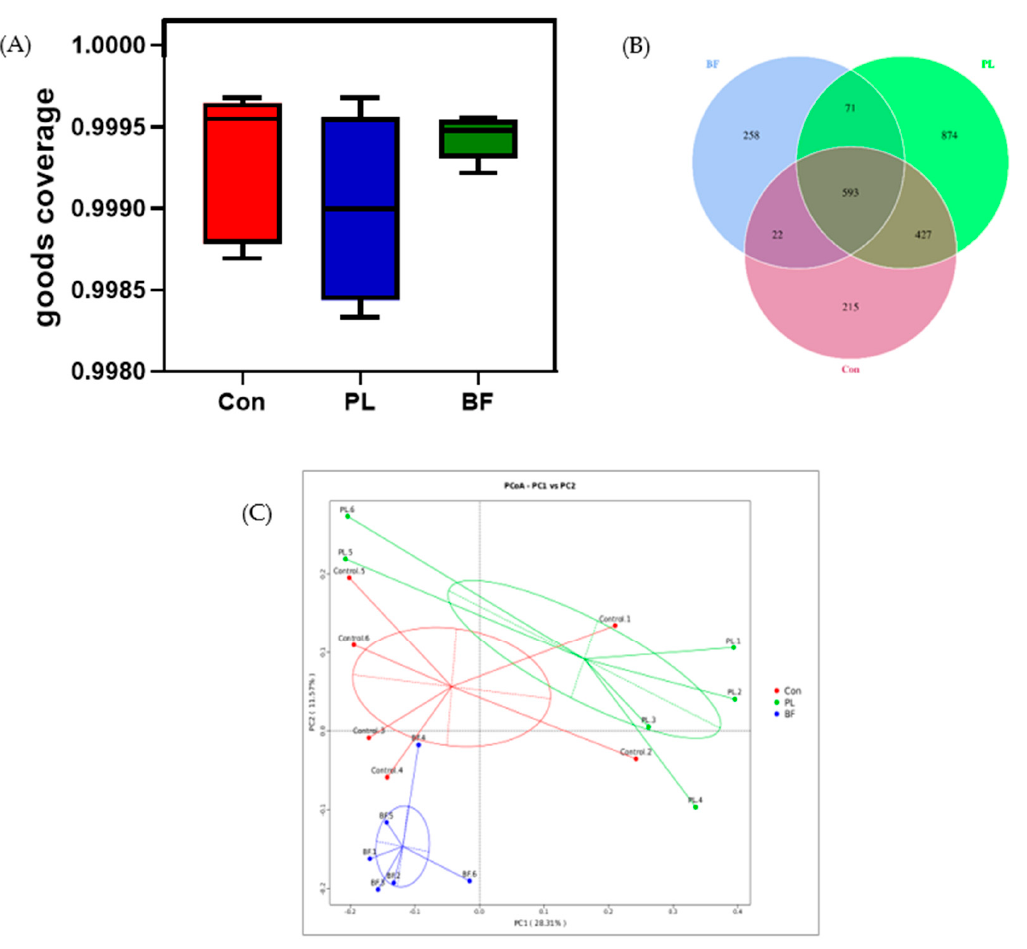
Figure 7. Goods coverage ( A ); OTUs Venn digram ( B ); PCoA plot, based on unweighted unifrac cluster (PCoA) of the data set ( C ). Note: Con means control group; PL means planktonic group; BF means biofilm group.